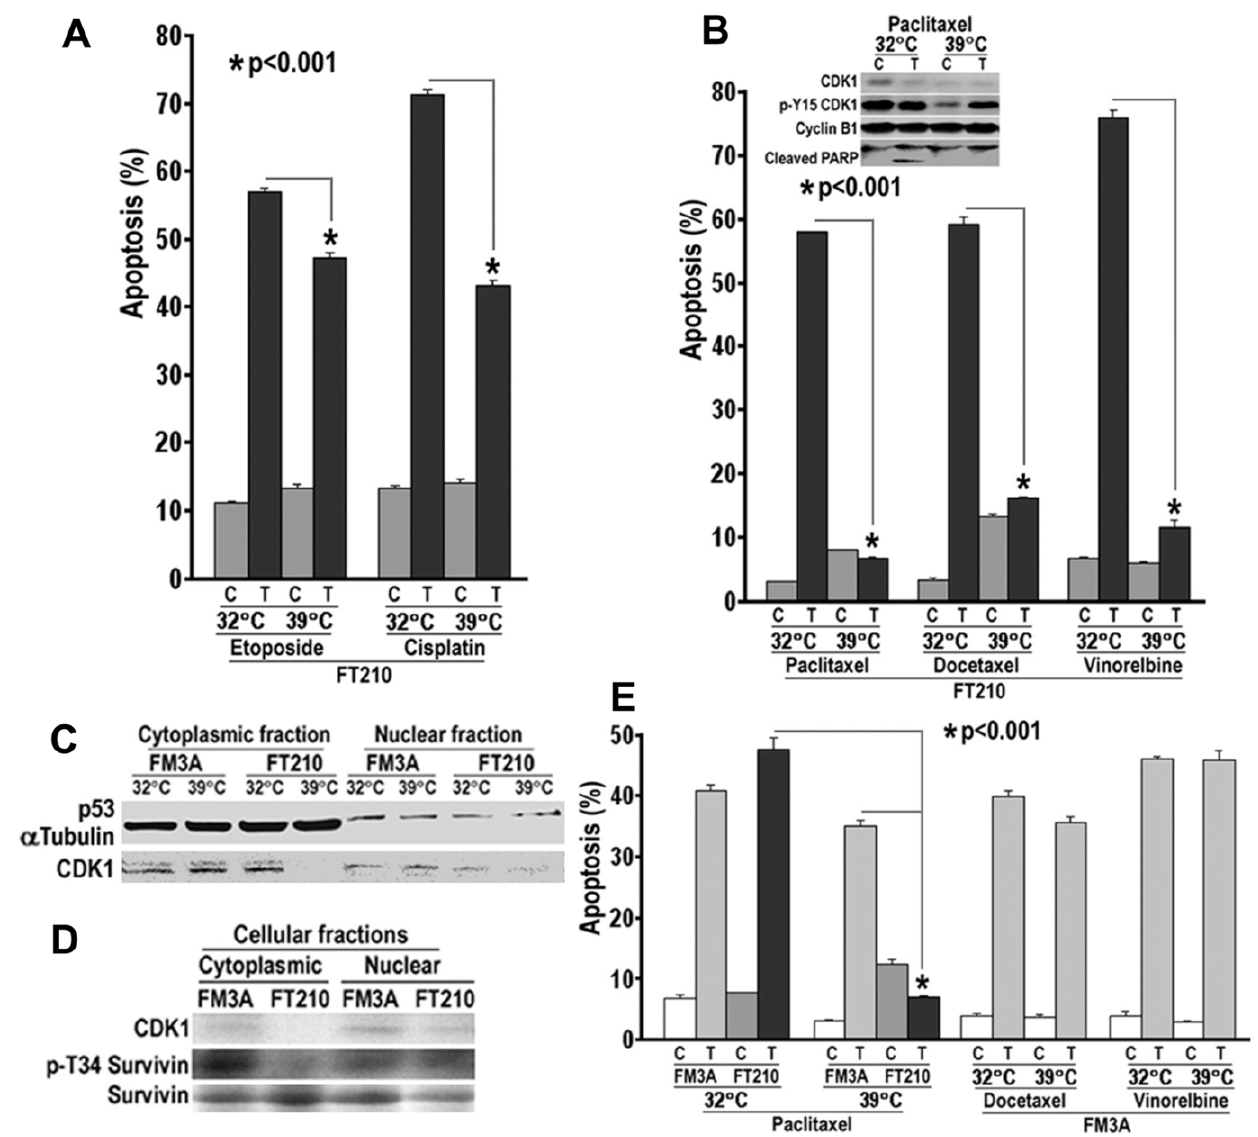
Figure 5. Loss of CDK1 protein and activity and chemotherapeutic resistance. A. FT210 cells were serum-starvated in 0.1% FBS RPMI1640 medium overnight, then treated with 10 m M etoposide or cisplatin in 0.1% FBS containing medium for 4 days at 32 u C or 39 u C. Apoptosis (sub-G1 DNA content) was determined by flow cytometry (C: Control; T: Treatment). B. FT210 cells were cultured in normal medium and treated with 1 m M paclitaxel or docetaxel and 0.1 m M vinorelbine for 1–4 Days. The CDK1 protein was detected at Day 3 using CDK1 or p-Y15 CDK1 antibodies, and apoptotic death was monitored by PARP cleavage. Apoptosis was determined at Day 4. C. FT210 and its parental cell line FM3A cells were cultured for 6 h then subjected to subcellular fractionation for immunoblotting analysis. a Tubulin and p53 served as loading controls for cytoplasmic and nuclear fractions, respectively. D. FM3A and FT210 cells were cultured at 39 u C for 72 h and subjected to subcellular fractionation. Expression of CDK1, p- Survivin (Thr34) and Survivin was assessed by immunoblotting. E. FM3A and FT210 cells were treated with 1 m M paclitaxel or docetaxel and 0.1 m M vinorelbine. Apoptosis was determined at Day 4.